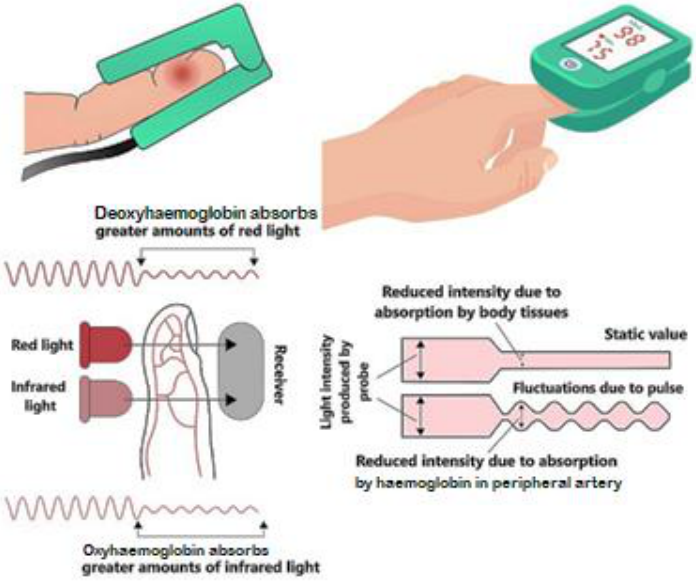
Figure 4. Impact of infrared light on oxygenated and deoxygenated